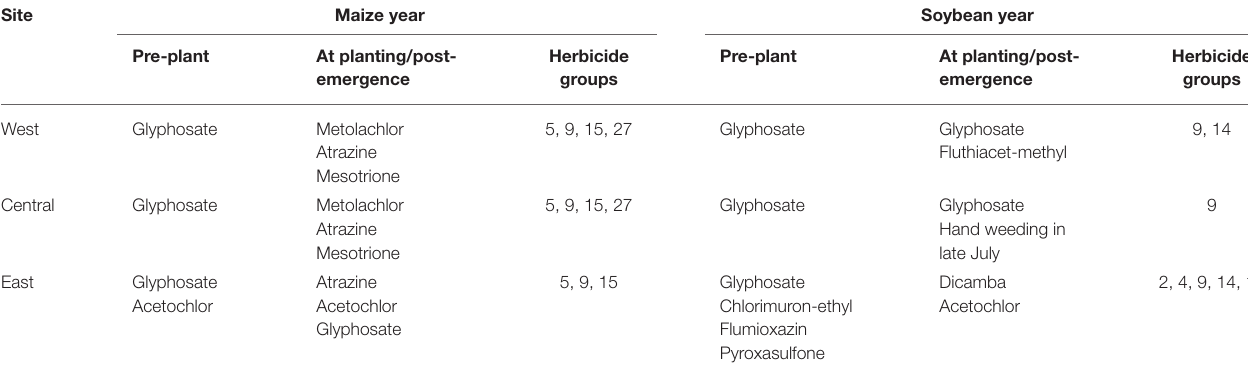
TABLE 2 | Summary of herbicide active ingredients applied at each site during 2017–2019 growing